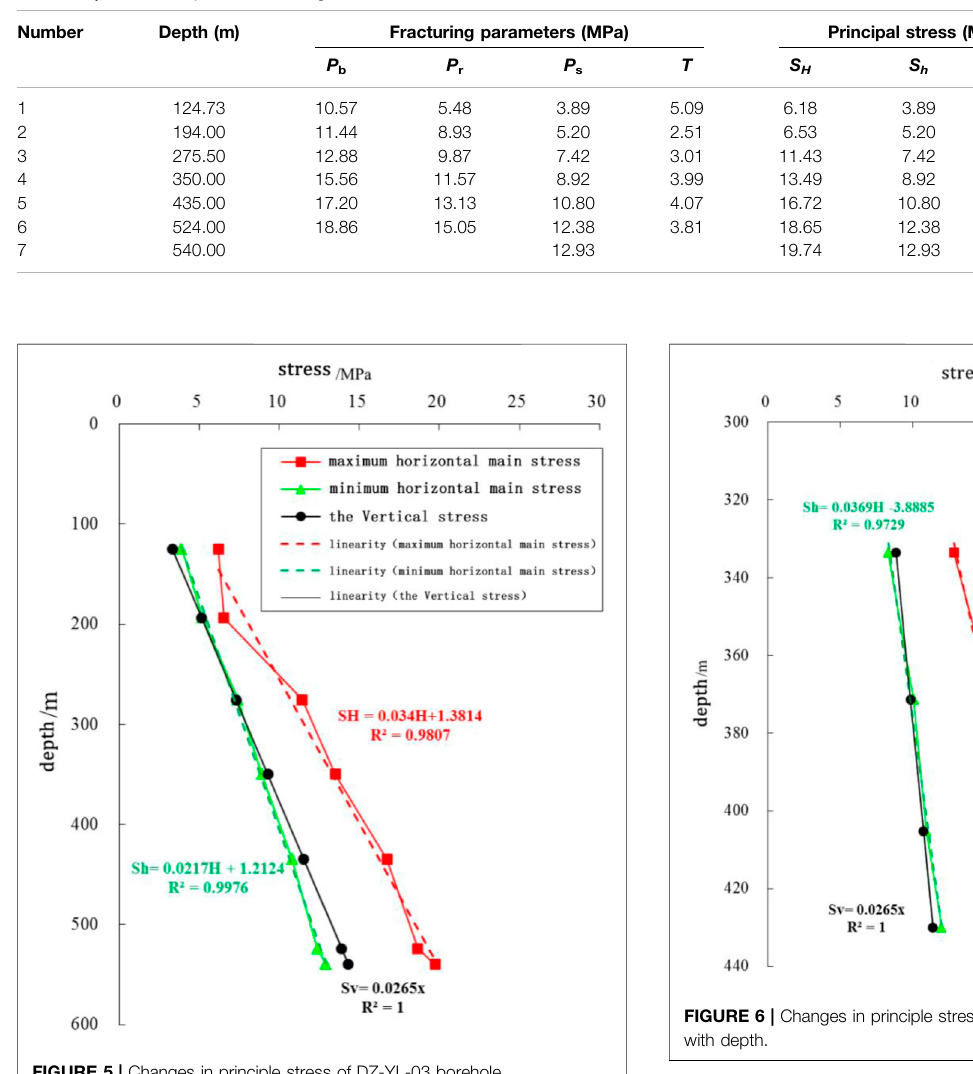
FIGURE 5 | Changes in principle stress of DZ-YL-03 borehole with depth.